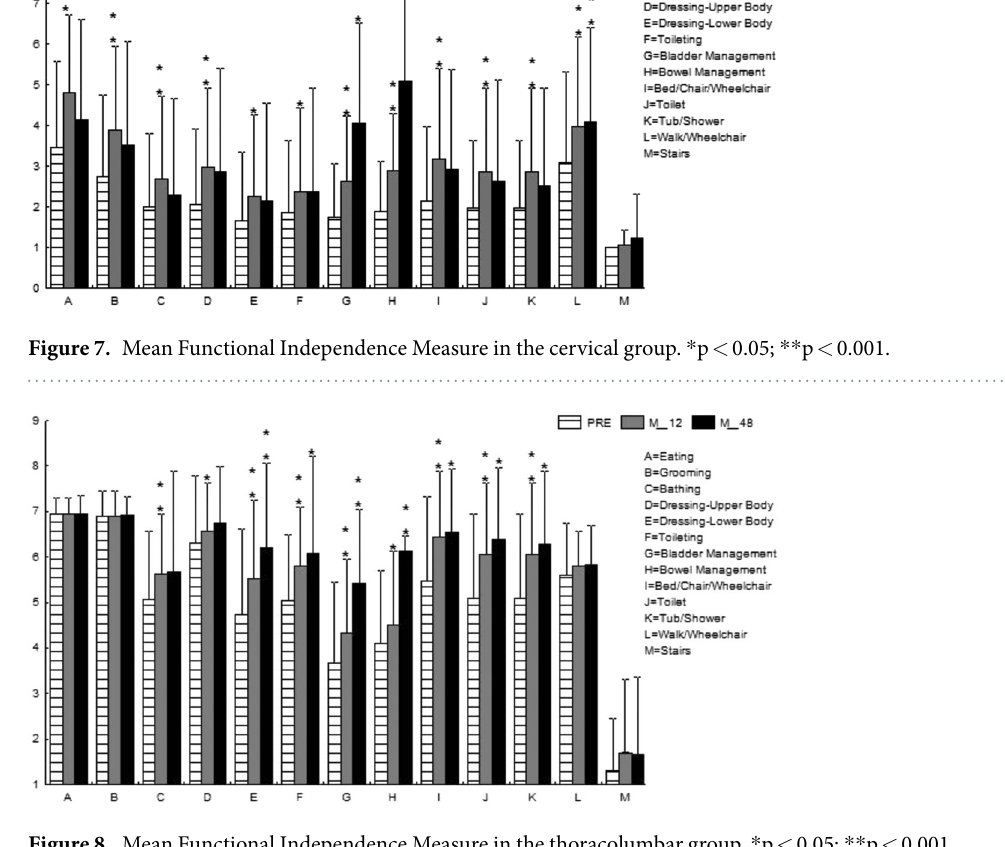
Figure 8. Mean Functional Independence Measure in the thoracolumbar group. * p < 0.05; ** p <